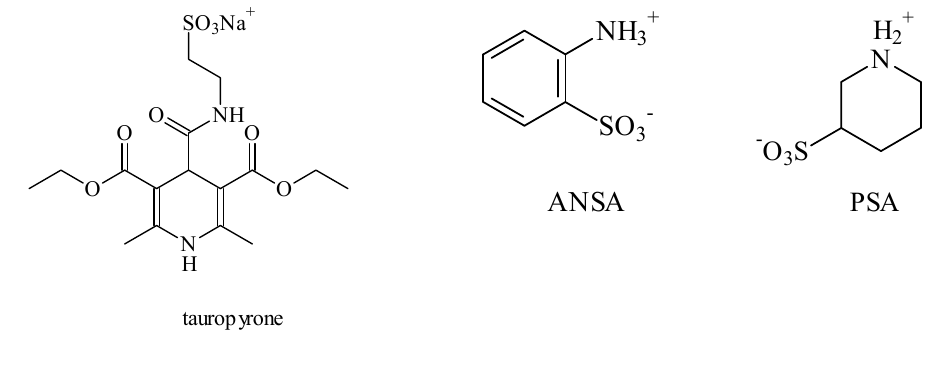
Figure 10. Structures of tauropyrone, piperidine 3-sulfinic acid (PSA), aniline 2-sulfinic